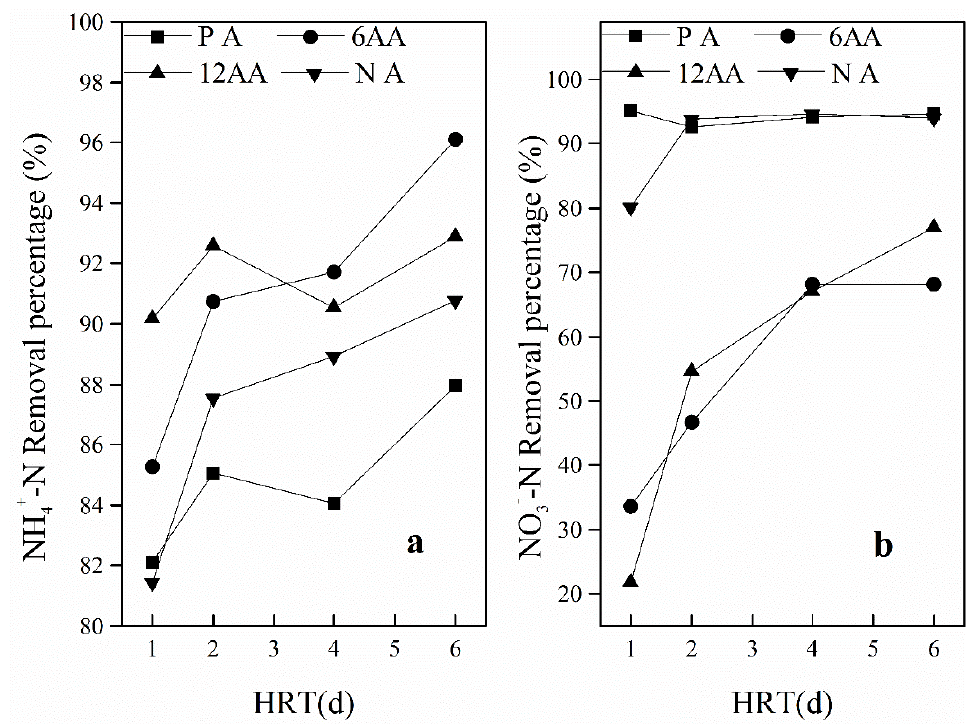
Figure 4. The removal efficiencies of NH 4+ -N ( a ) and NO 3 − -N ( b ) in HSSF-CWs with different aeration modes. (PA: Pre-aeration at 24 h before the input of influent water; 6AA: Aeration at 6 h after the input of influent water; 12AA: Aeration at 12 h after the input of influent water; NA: Non-aeration)